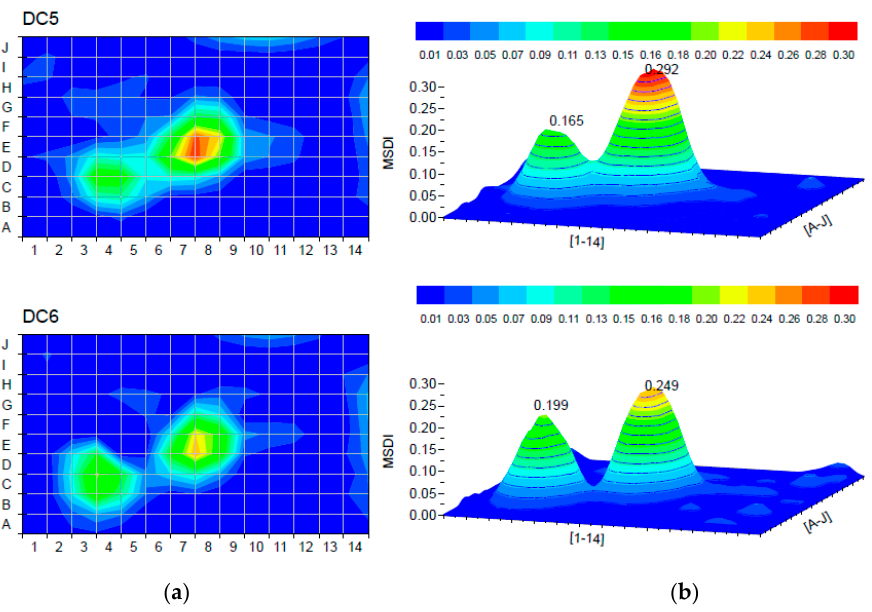
Figure 9. Damage localization for damage cases DC5 and DC6: ( a ) 2D; ( b ) peak values in